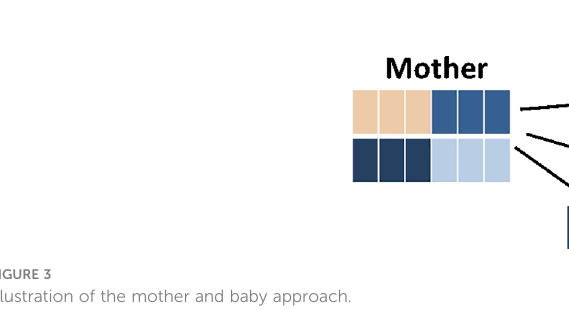
TABLE 2 Characteristics of crop cultivars used. Cultivar Cycle (day) Seed color Grain yield (t/ha)